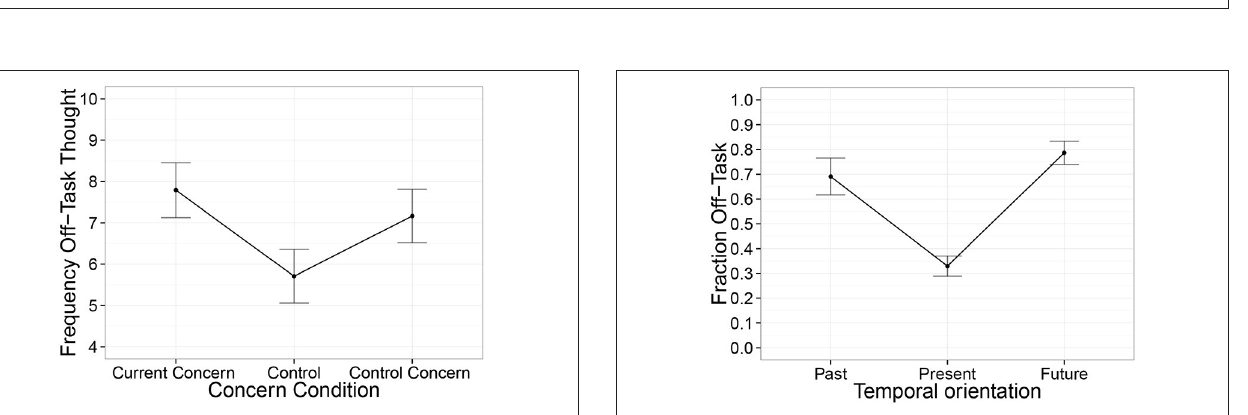
FIGURE 3 | Frequency of off-task thinking by current concern condition. Number of off-task thinking reports is increased in the current concerns condition relative to the control condition. Error bars reflect standard errors.